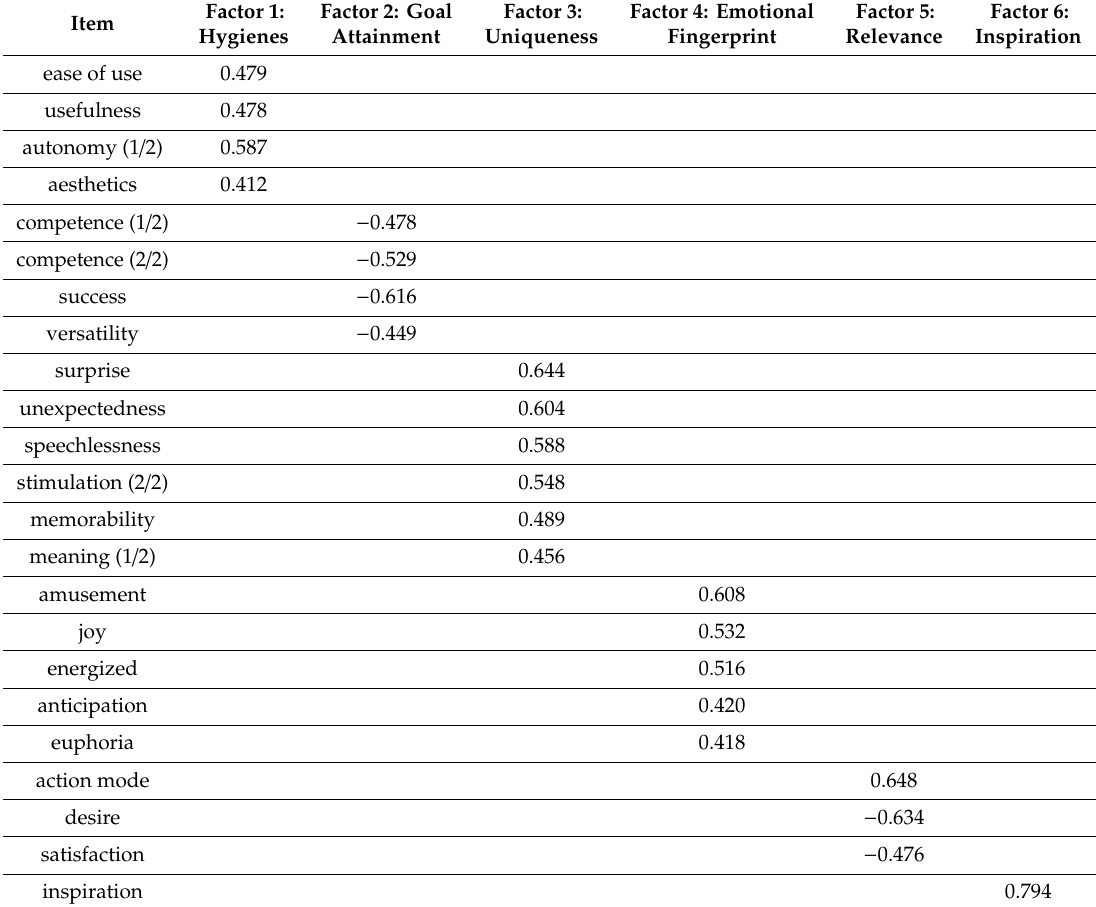
Table 5. Pattern matrix (rescaled and sorted; factor loadings below 0.4